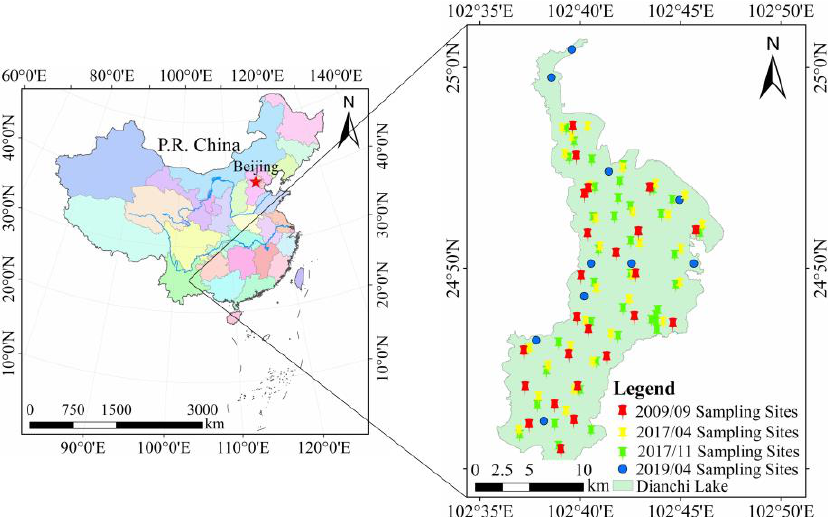
Figure 1. Dianchi Lake and sampling sites location distribution in China. The chromatic points indicate the sampling sites, and the light green area indicates Dianchi Lake. The red pushpins indicate the sampling sites in April 2009, the yellow pushpins represent the sampling sites in April 2017, the green pushpins denote the sampling points in November 2017, and the blue dots refer to the sampling points in April 2019.